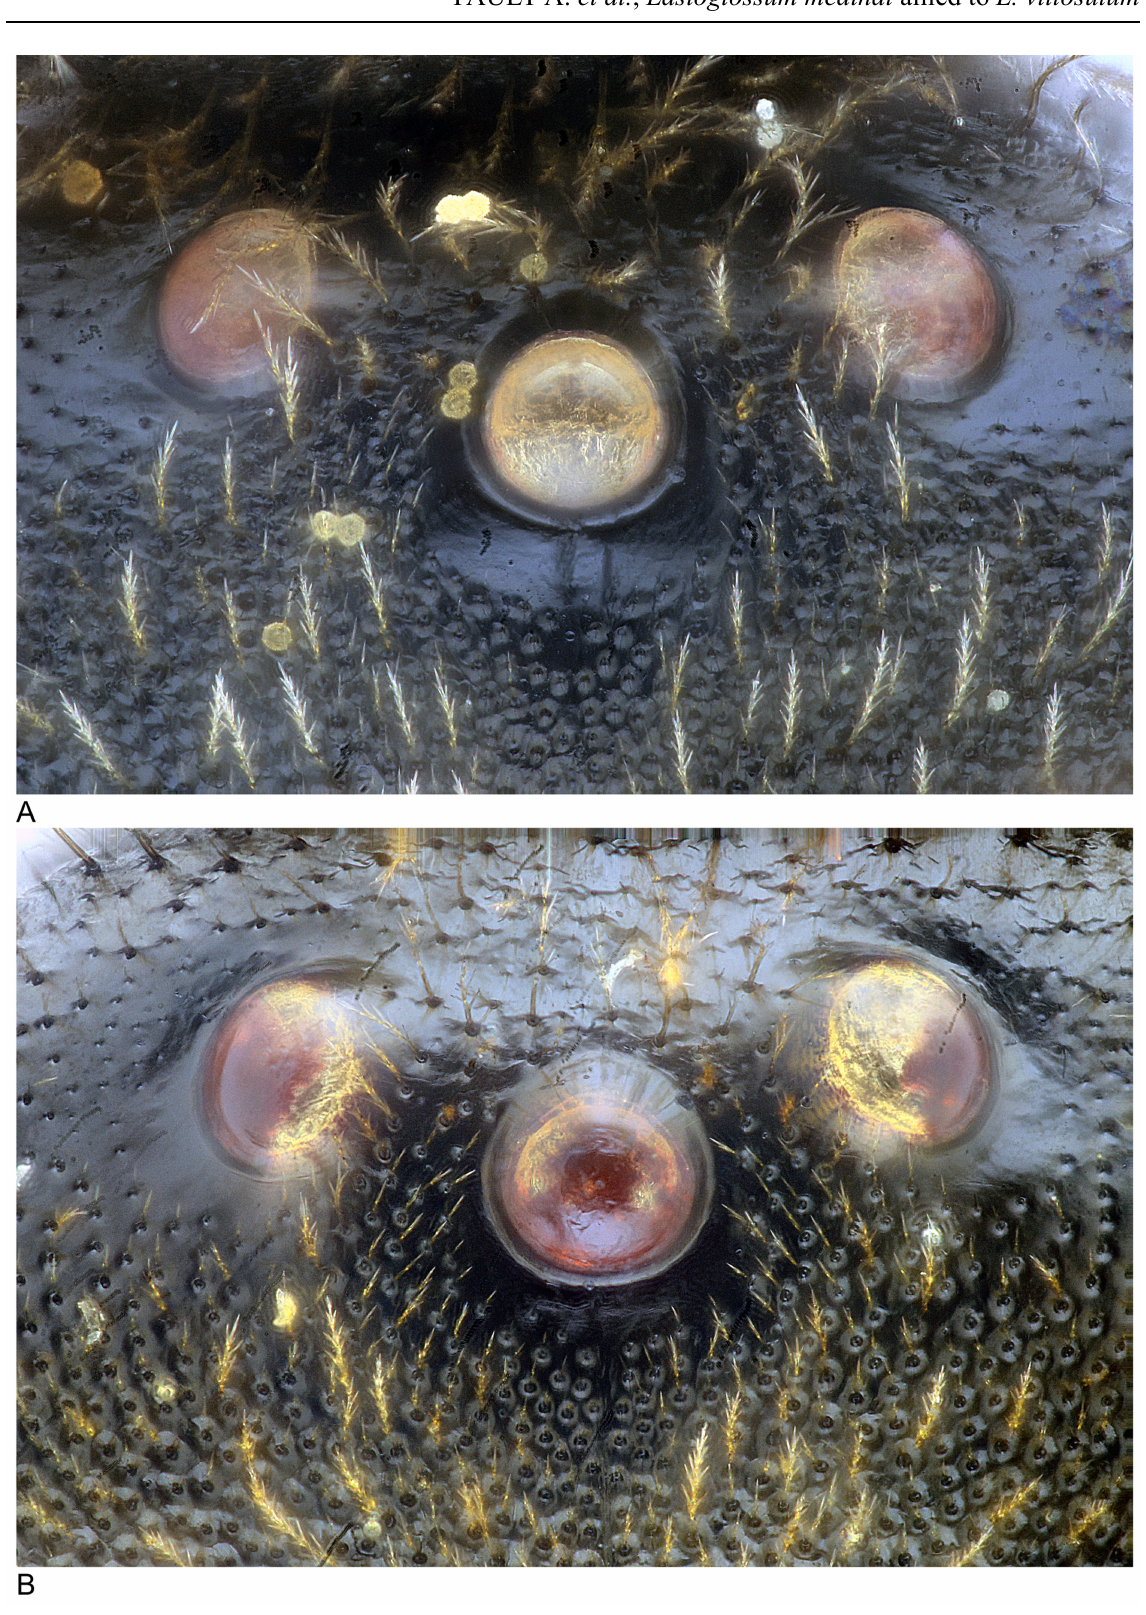
Fig. 19. Punctation in front of the medial ocellus of females. A . Lasioglossum medinai (Vachal, 1895) (France: Uchaux). B . L. villosulum (Kirby, 1802)